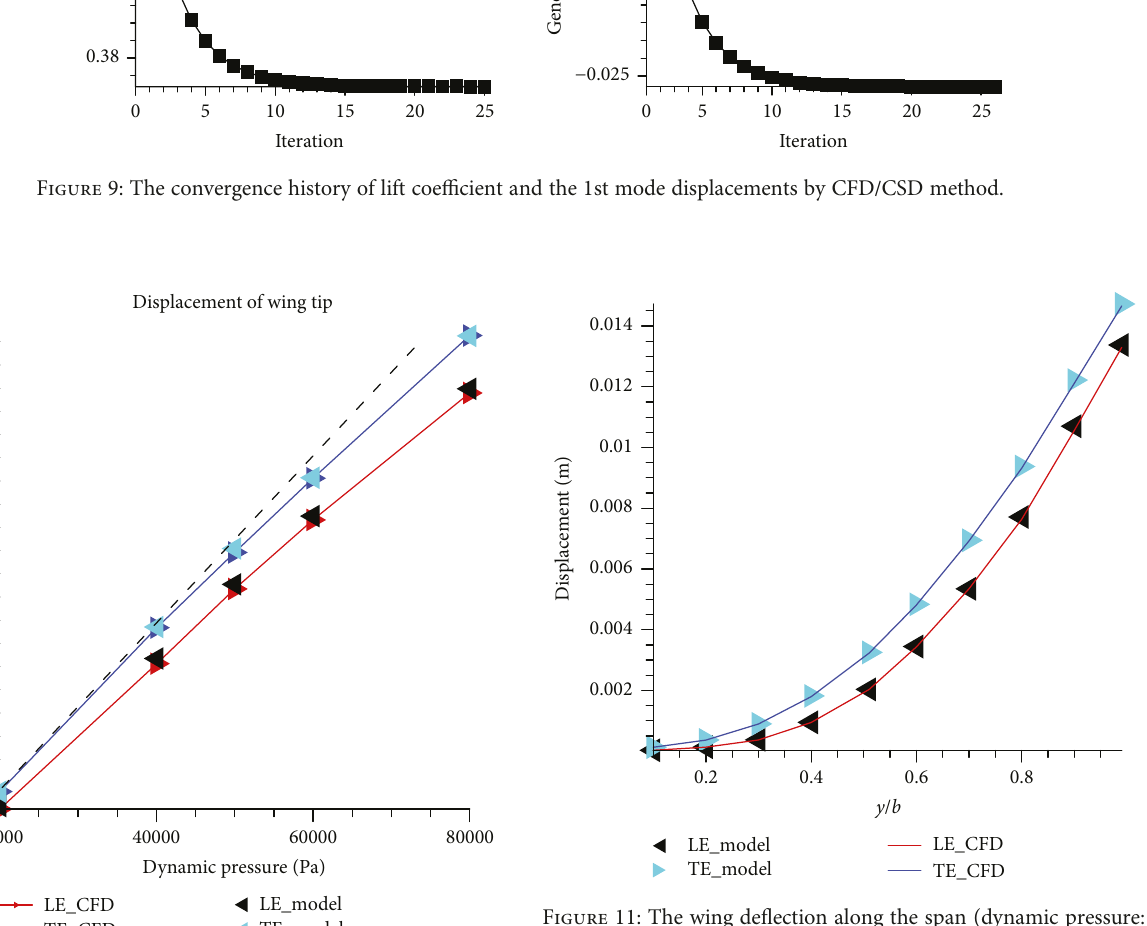
Figure 11: The wing de fl ection along the span (dynamic pressure: 40055.5